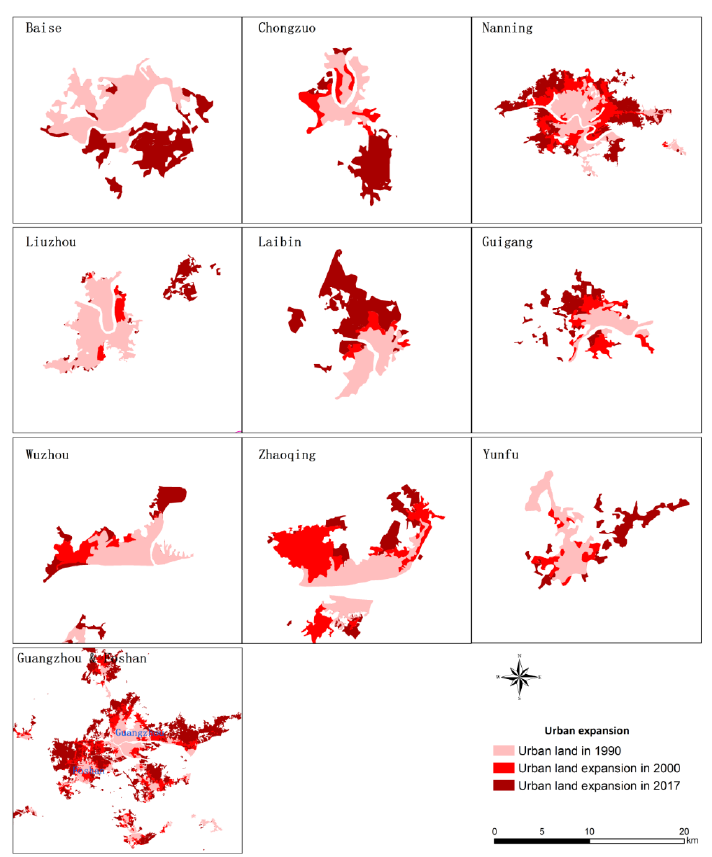
Figure 8. Urban expansion in eleven prefecture ‐ level cities in the ZXEB (1990, 2000, and 2017). Note: Guangzhou and Foshan are connected.